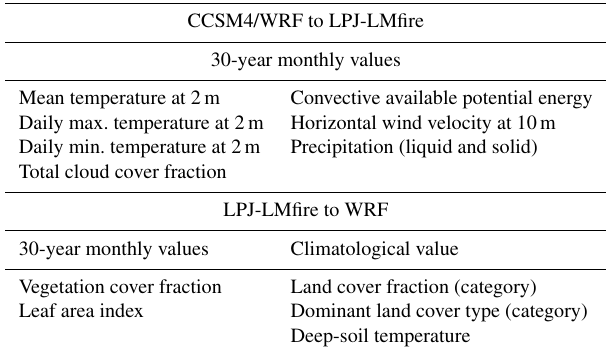
Table 2. Variables passed between CCSM4/WRF and